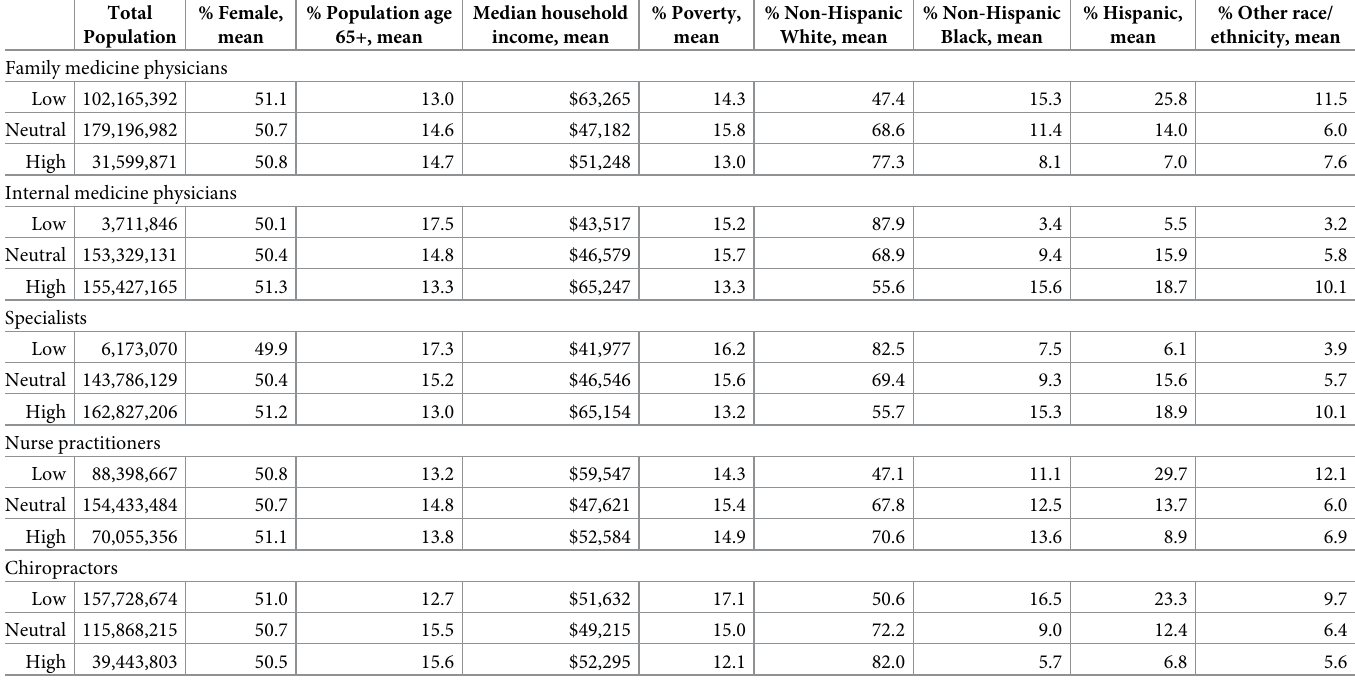
Low represent areas of low clustering at 99% confidence level, Neutral represents areas with no significant clustering, and High represents areas of high clustering at 99% confidence level. All population characteristics were taken from the 2010 US